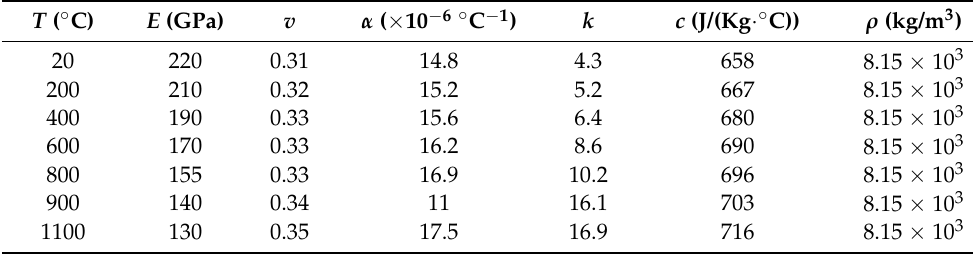
Table 1. Material parameters of GH3128 for SUB layer [48–51].